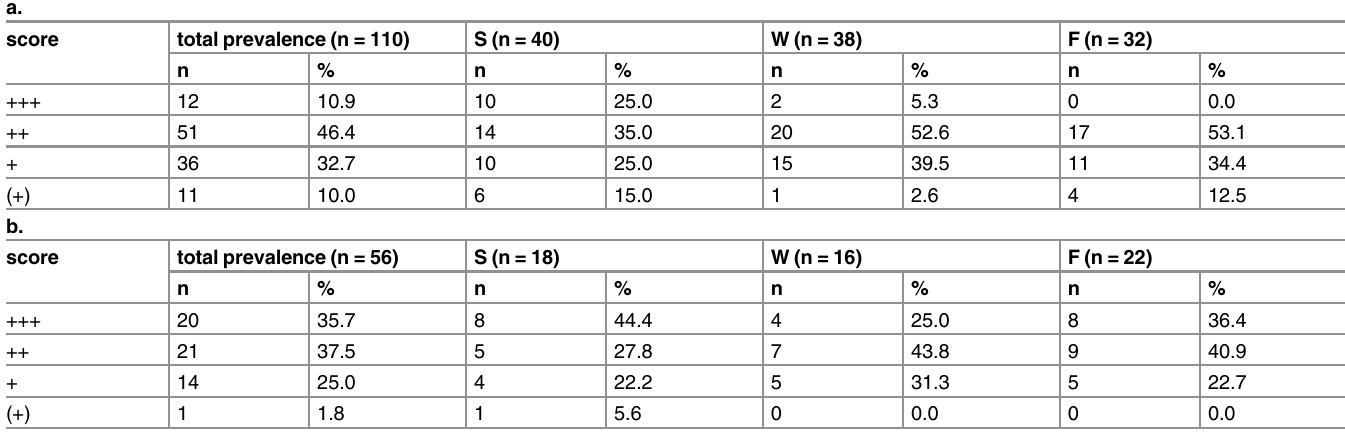
Table 3. a. Semiquantitative ISH results for Pneumocystis spp. b. Semiquantitative ISH results for PCV2. S = suckling piglets, W = weaning piglets, F = fattening pigs; n = number of samples.